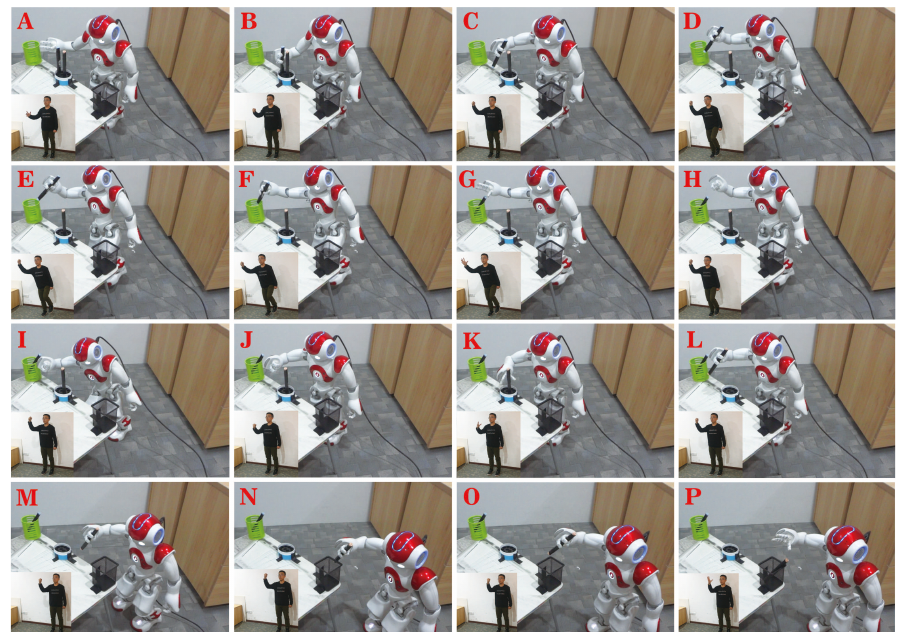
Figure 19. Snapshots of the robot and the human in the task-oriented teleoperation experiment.